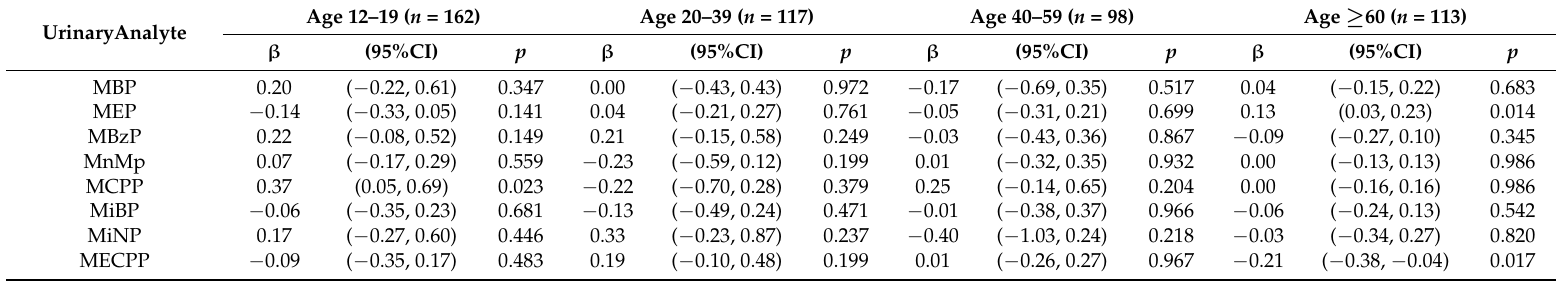
Table 5. Associations between urinary phthalate metabolites and serum anti-Müller hormone level in males, NHANES 2003–2004 (unadjusted).